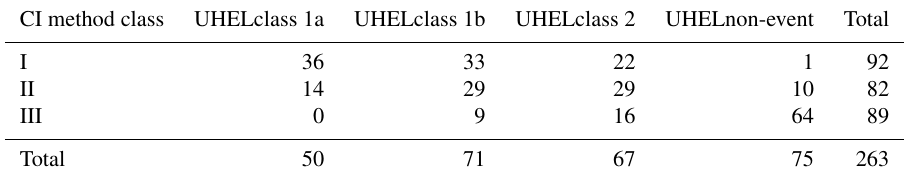
Table 3. Comparison of two classification schemes for new particle formation events: the CI method (Class I, Class II and Class III; see Table 2) and the University of Helsinki (UHEL) classification originally reported in Dal Maso et al.